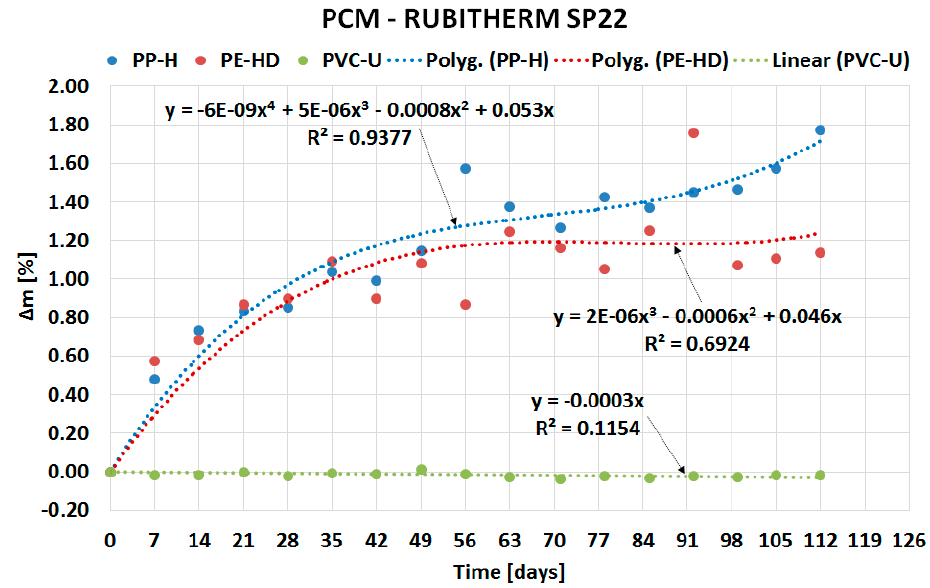
Figure 5. Dependence of mass change of tested plastics on duration of the experiment for SP22.